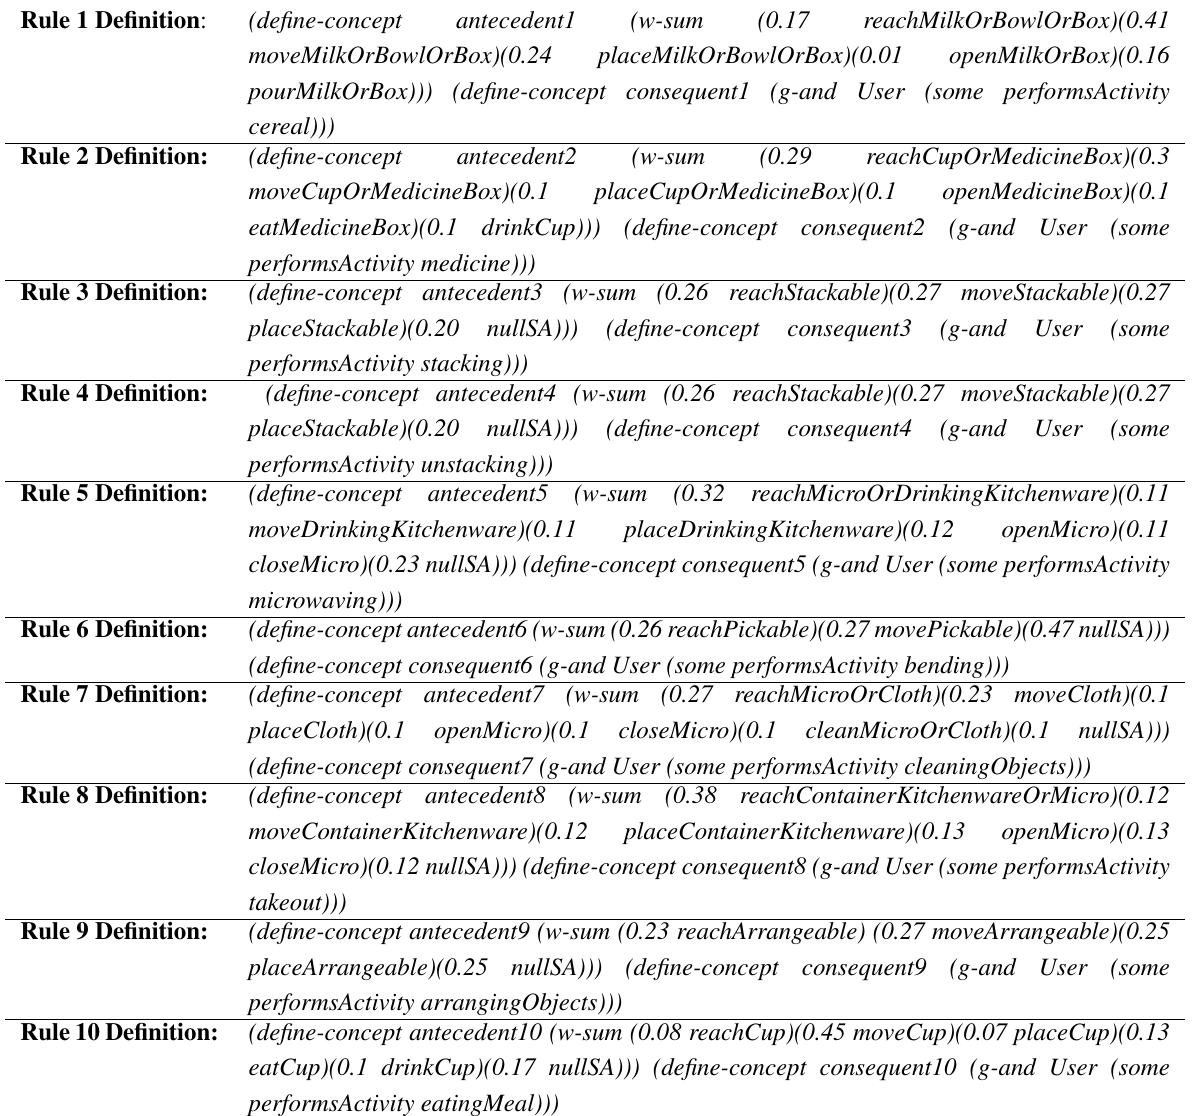
Table 5. Fuzzy rules for each